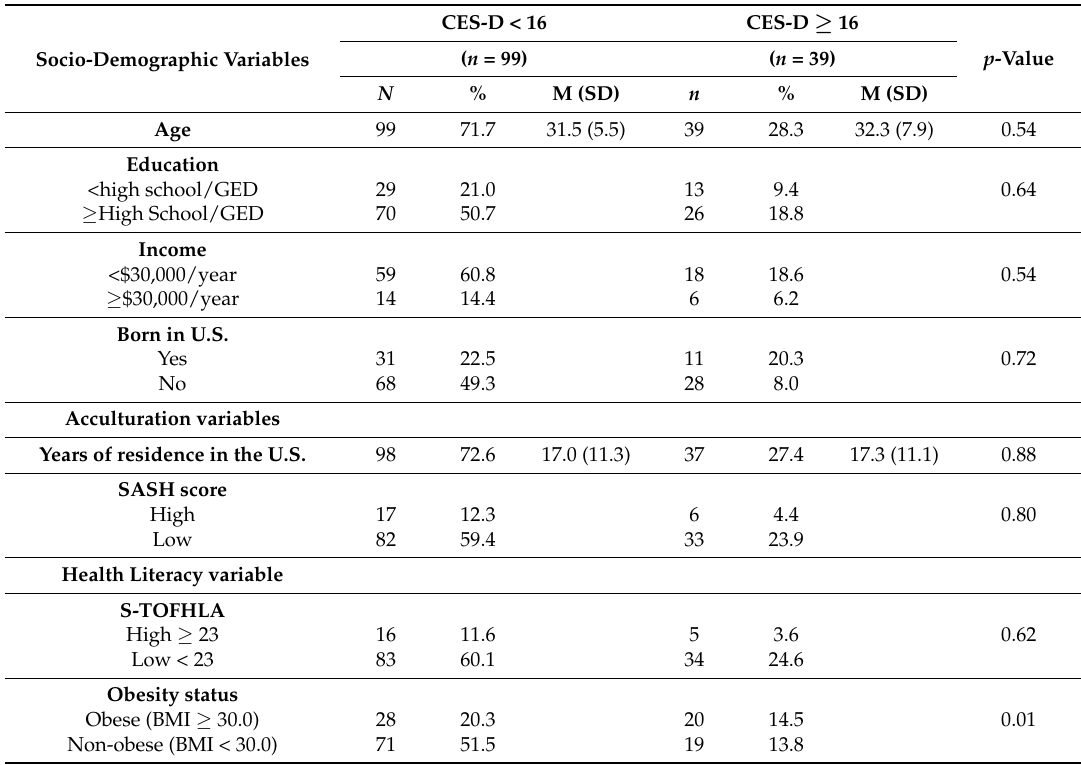
Table 2. Prevalence of elevated depressive symptoms by CES-D cut-off scores and selected variables among low-income Latina mothers ( n =